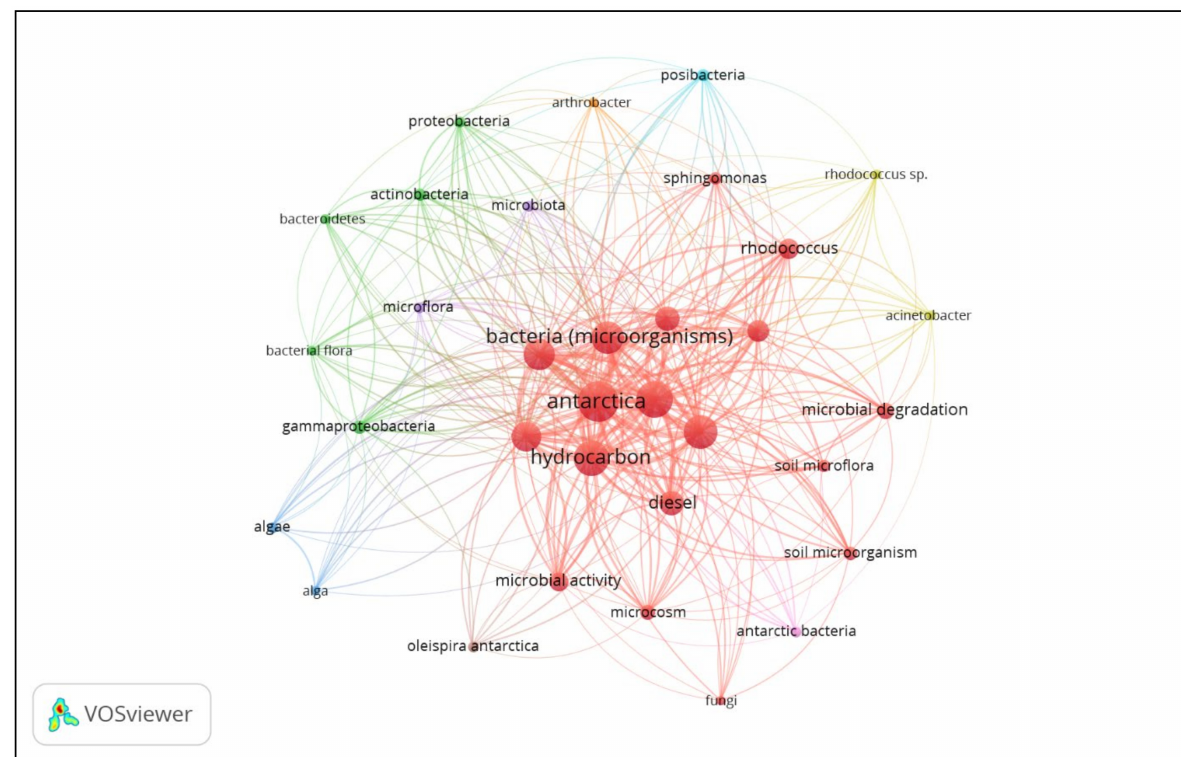
Figure 3. Network visualisation map of keywords in literature related to Antarctic bioremediation of diesel created by VOSviewer ©2021 Centre for Science and Technology Studies, Leiden University, The